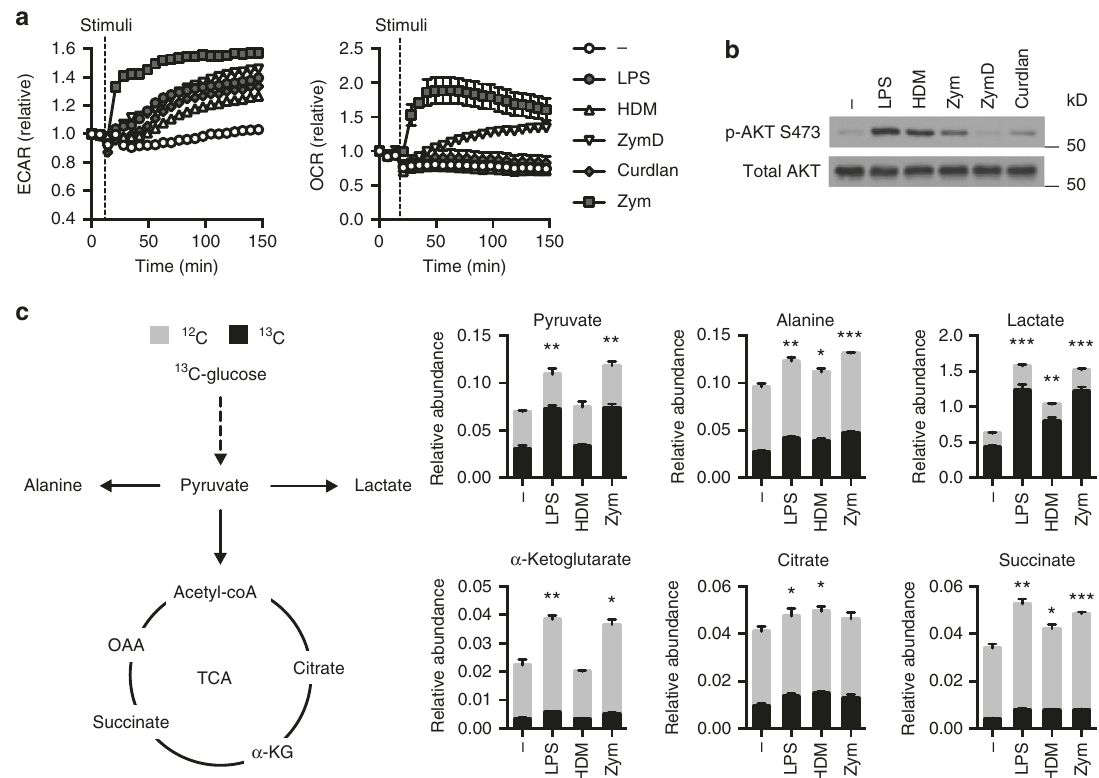
Fig. 2 Weakly activated DCs undergo early glycolytic fl ux. a Indicated stimuli were injected onto DCs using the Seahorse Bioanalyzer and ECAR (left) and OCR (right) were measured in real-time. b Immunoblot for total AKT and AKT phosphorylated at Ser473 in DCs following 1 h of stimulation. c The relative abundance of various metabolites determined by GC-MS after activation for 2 h and pulse with 13 C-glucose. Data shown are one experiment representative of ( a ) more than three experiments, ( b) three experiments, and ( c ) two experiments (mean and s.e.m. of 9 (unstimulated) or 10 (stimulated) replicates ( a ) or triplicates ( c )). Statistical analysis shown in c is for the comparison of the 13 C-labeled fraction between each condition and the control condition